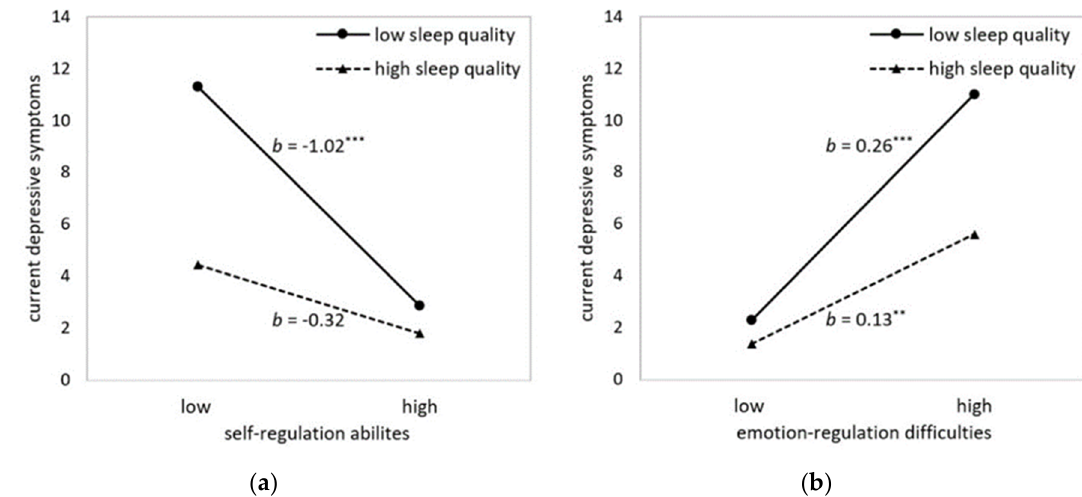
Figure 2. Illustration of the interactions in predicting current depressive symptoms (BDI-II’1): ( a ) between sleep quality and self-regulation abilities (REG) and ( b ) between sleep quality and emotion regulation difficulties (DERS). High sleep quality corresponds to low PSQI scores. Values show estimates at means ±1 SD for all predictors. Asterisks denote slopes that are significantly different from zero. ** p ≤ 0.01, *** p ≤ 0.001.